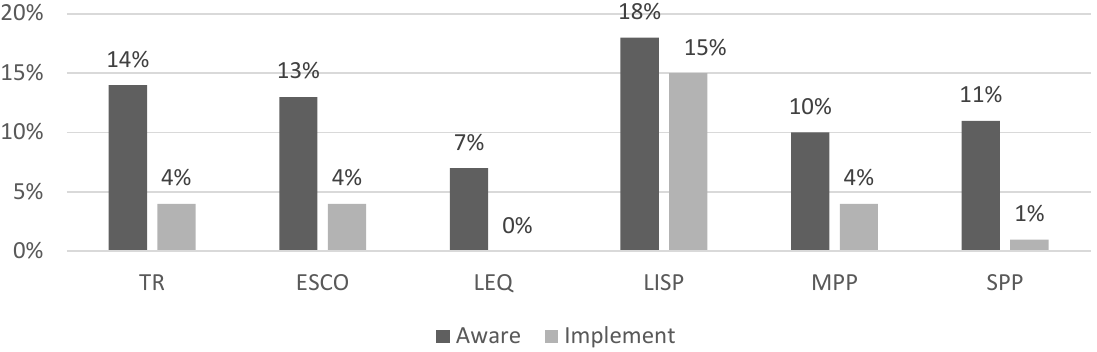
Figure 3. Percentage of awareness and implementation of the organizational and financial mechanisms for the implementation of projects in the area of increasing the energy